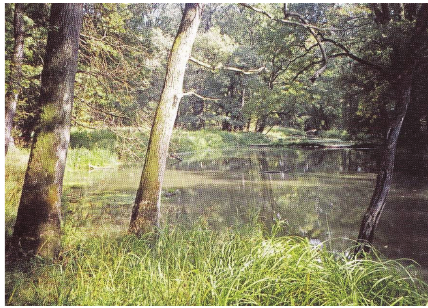
Figure 9: Artificial regeneration of oak ( Quercus robur L.